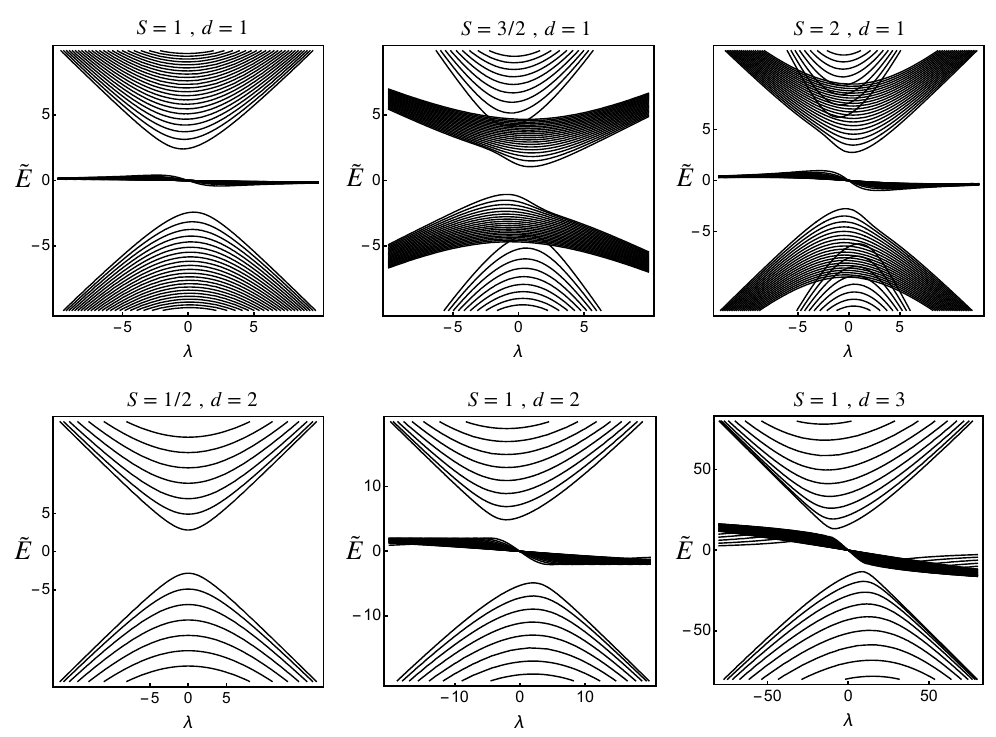
obtained with the anzatz H op